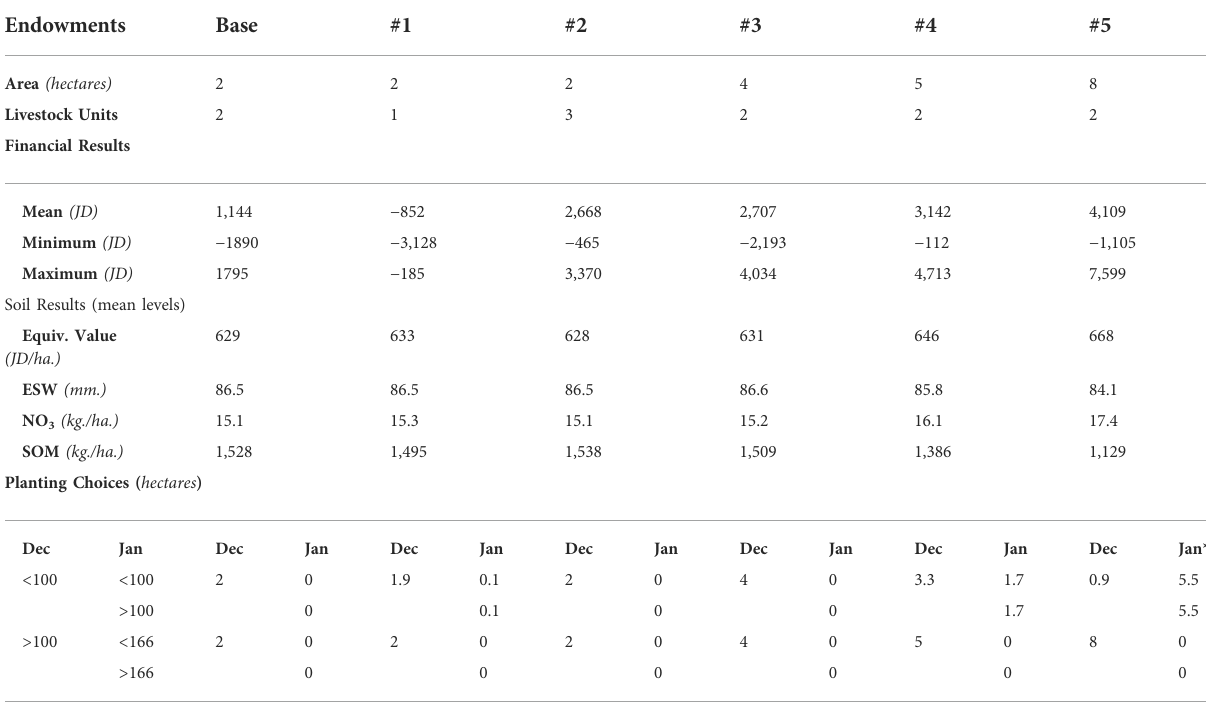
TABLE 1 Results from base soil, varying land and livestock unites. Scenarios varying area and livestock